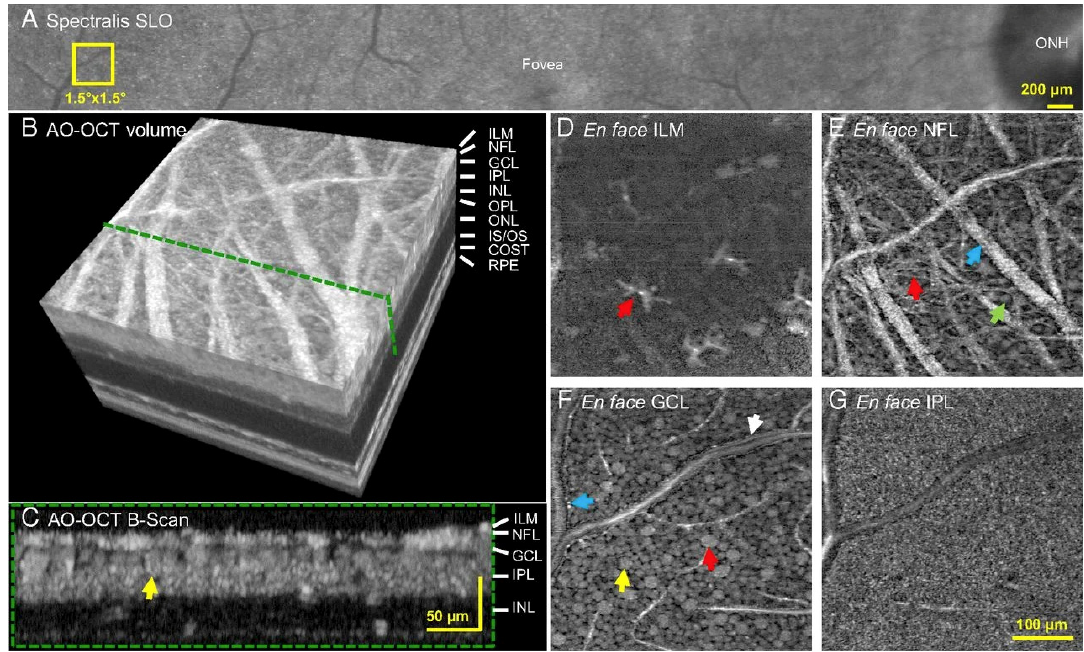
Figure 3. Adaptive optics (AO) OCT showcasing cellular structures of the retina. Yellow 1.5 × 1.5 box in ( A ) (Spectralis scanning laser ophthalmoscope) showcases location imaged by AO-OCT. ( B ) 3D AO-OCT with layers and green dotted line showcases the cross-section of the retina in ( C ) with yellow arrow highlighting ganglion cell layer soma. ( D – G ) Different layers of the retina (internal limiting membrane, nerve fiber layer, ganglion cell layer, and inner plexiform layer). ( D ) Red arrow shows astrocyte/microglial cells. ( E ) Blue arrow shows nerve fiber webs. ( F ) Red arrow shows large soma, yellow arrow shows ganglion cell layer soma, blue and white arrows show edges of vessel walls. ( G ) Synaptic connections in the internal plexiform layer. Reprinted with permission from Liu et al. [50] . Imaging and quantifying ganglion cells and other transparent neurons in the living human retina. Proc Natl Acad Sci. U S A 2017;114(48):12803-8 with license permissions obtained from Creative Commons; Creative Commons Attribution-Non-Commercial-No Derivatives 4.0 Interna- tional (CC BY-NC-ND 4.0, https://creativecommons.org/licenses/by-nc-nd/4.0/legalcode (accessed on 1 August 2022)).